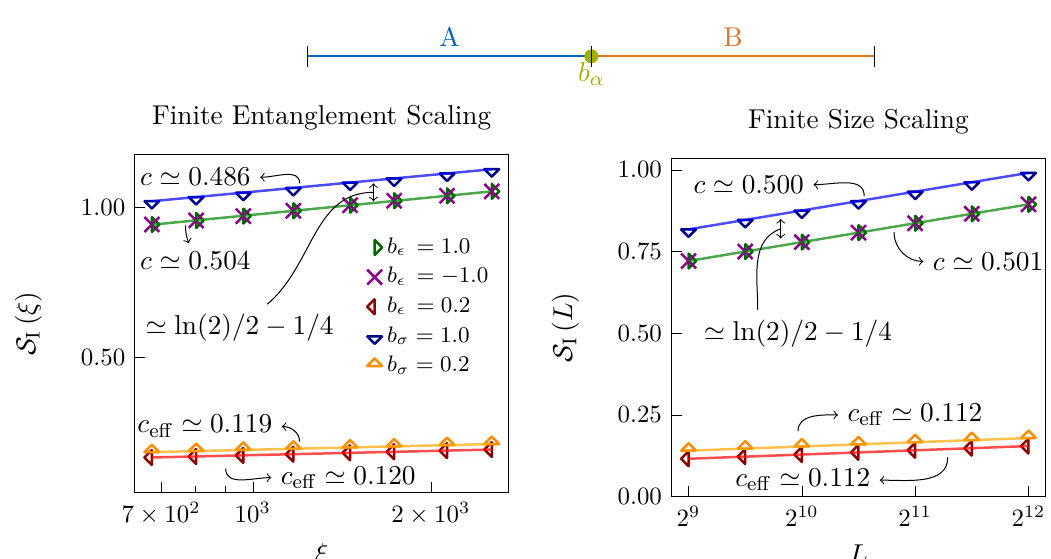
Figure 5 . Scaling of the interface EE, S I , with correlation length ( ξ ) and system size ( L ) for infinite (left panel) and open (right panel) bcs. For the infinite bc, the bond dimension ( χ ) was increased from 50 to 100 to increase the correlation length. For both bcs, the b (cid:15) = ± 1 and b σ = 1 , the coefficient of the logarithmic scaling [see eq. (3.3), with L → ξ for infinite bc] gives a central charge of c ’ 0 . 5 . The same for b (cid:15),σ = 0 . 2 leads to an effective central charge c eff ’ 0 . 112 , in agreement with see eq. (3.8). The fit errors obtained are in the fourth decimal places. We